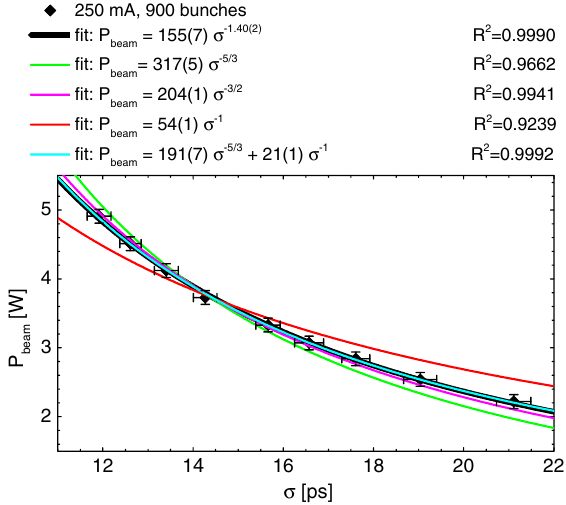
FIG. 2. The measured beam heat load as a function of bunch length for a filling pattern of 250 mA beam current in 900 consecutive bunches is shown together with the fits to the data corresponding to the best fit using a power law and five different rf effects. The adjusted coefficient of determination R 2 is also reported for each fit. bunch charge and a fixed bunch length. Additionally the bunch spacing has been varied; the red, green and blue points are taken from four different beam current ramps, where the bunches are consecutive in one train with a bunch spacing of 2 ns and a gap of 72, 502, 952, and 1412 ns at the end of the train for the filling pattern with 900, 685, 460 and 230 bunches, respectively. The cyan points are taken from a measurement where the bunch spacing was varied from 8 to 52 ns by distributing the bunches equally along the storage ring.